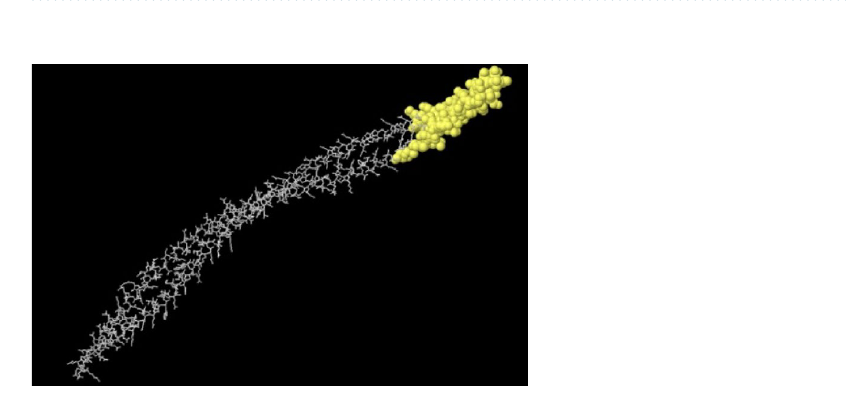
Table 4. Predicted conformational epitopes of the final designed vaccine by the ElliPro server.